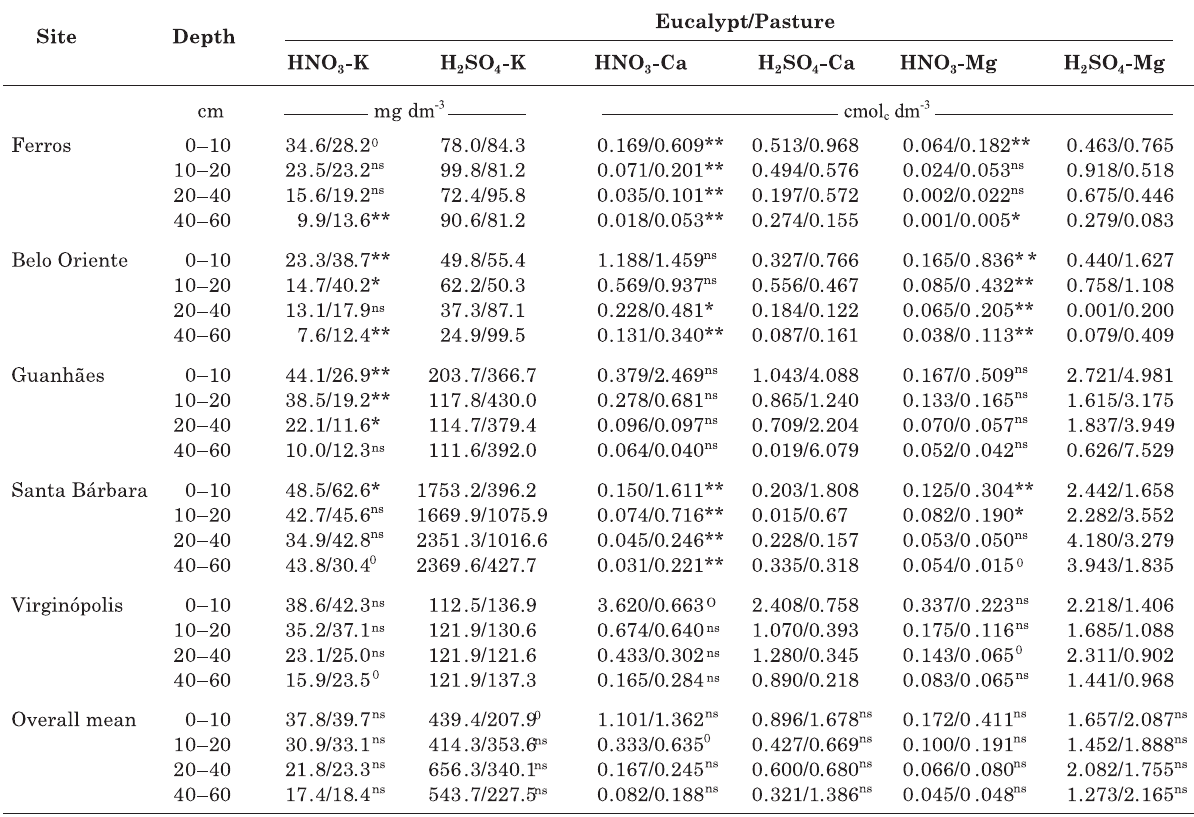
Table 4. Concentrations of available (Mehlhich-1), non-exchangeable (extracted by HNO (extracted by sulfuric acid) K, Ca, and Mg in soil samples at different depths cultivated with eucalyptus/ pasture in five areas of the Rio Doce Valley